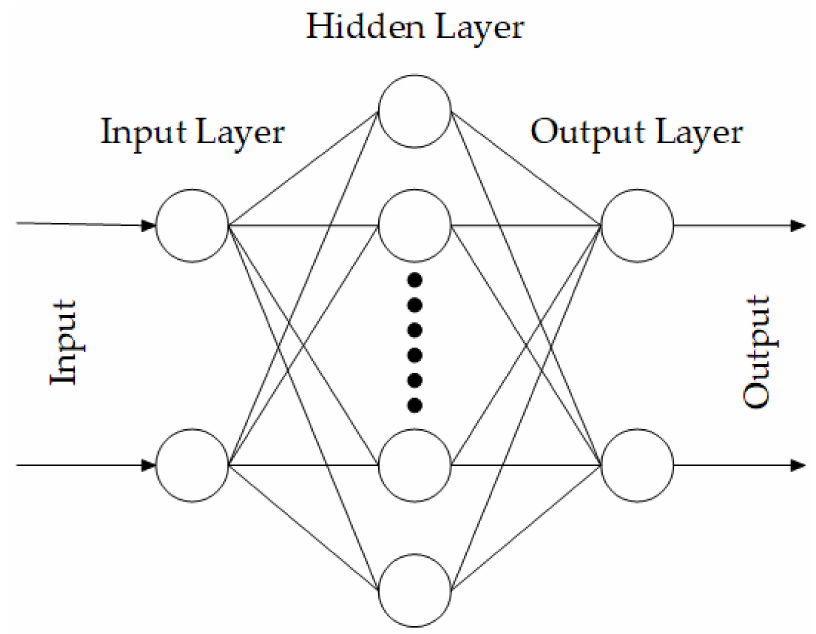
Figure 2. Schematic of the neural network